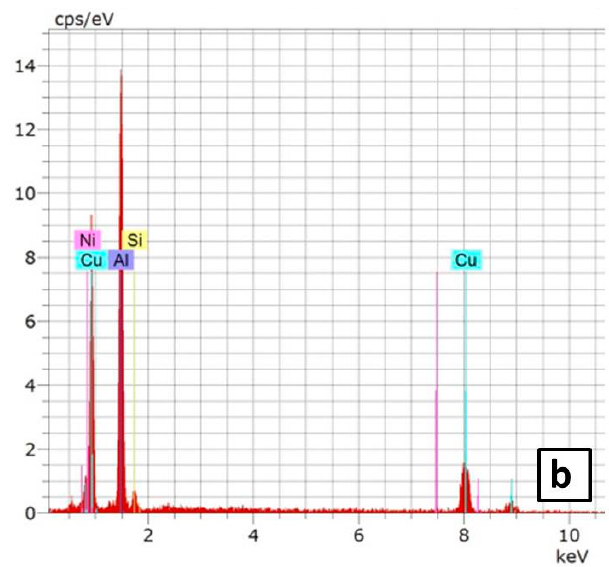
Figure 10. Microstructure and EDS analysis of the formed composite of 6% Cu after the heat treatment at 380 °C for 18 h; ( a ) enlarged SEM image and ( b ) EDS spectra the red area in ( a ).